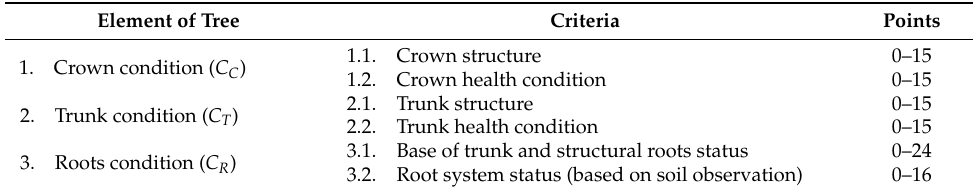
Table 2. Range of points for each of the criteria. Element of Tree